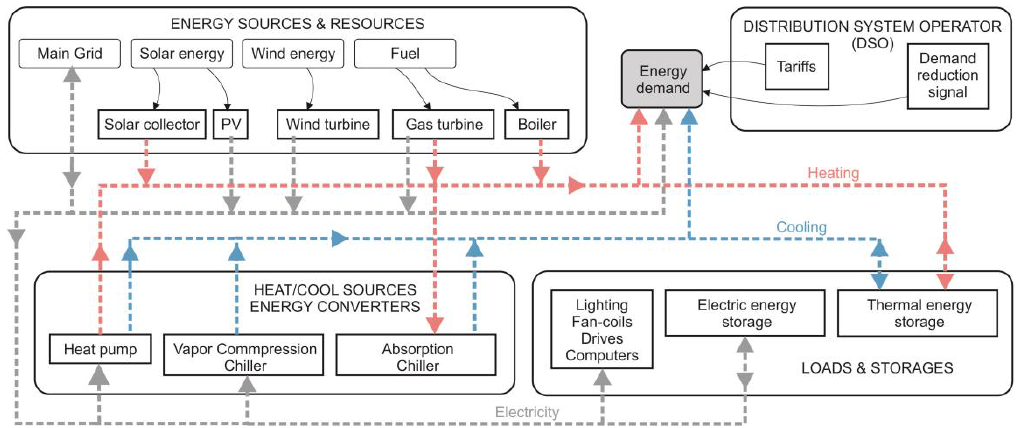
Figure 1. A model of a prosumer microgrid architecture with technical infrastructure and power (energy) flow channels.